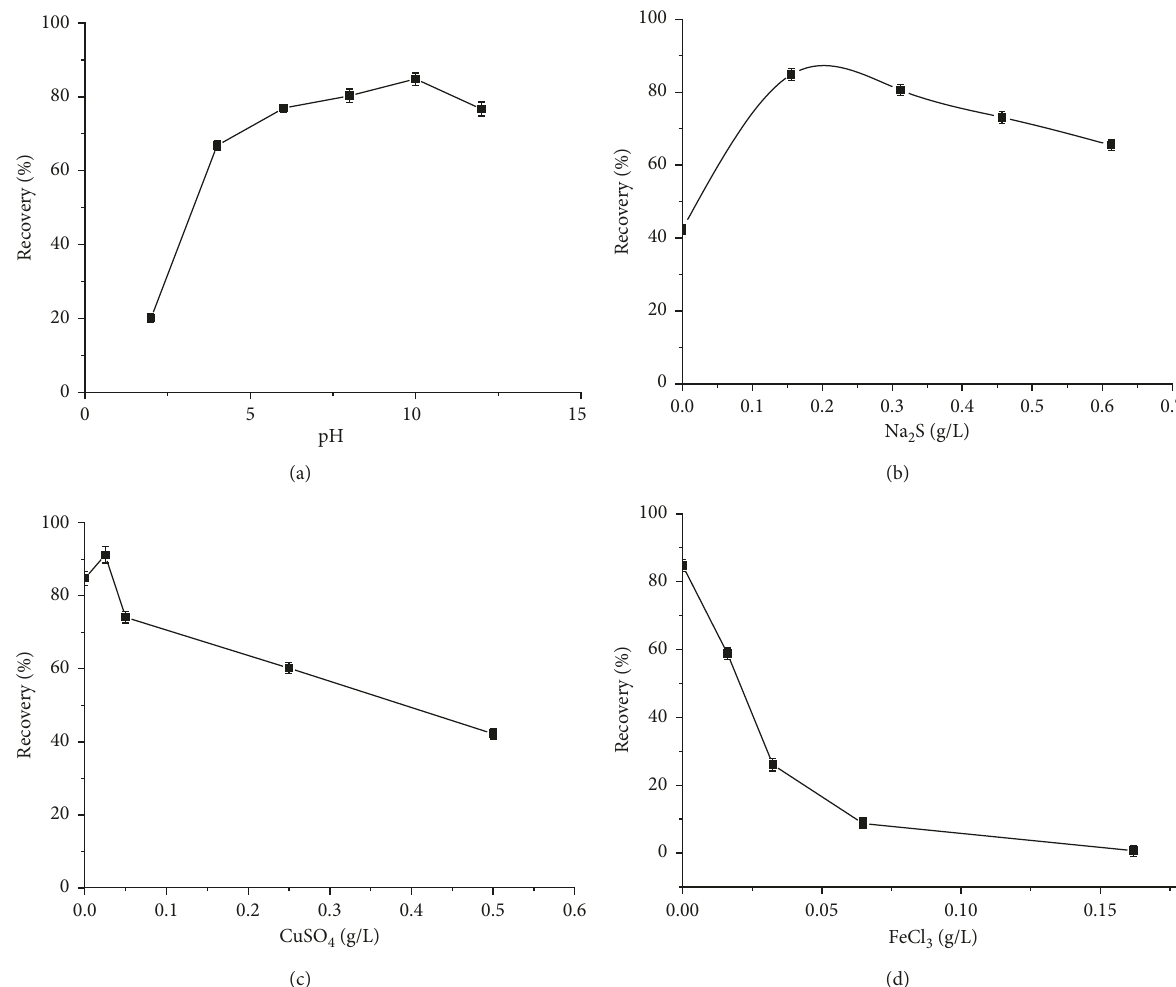
Figure 3: Recovery of CuO under different conditions: (a) different pH values (Na neither CuSO 4 nor Fe 3 Cl addition); (c) different CuSO 4 concentrations (pH � 10, Na 2 S 0.156g/L); (d) different Fe 3 Cl concentration (pH � 10, Na 2 S